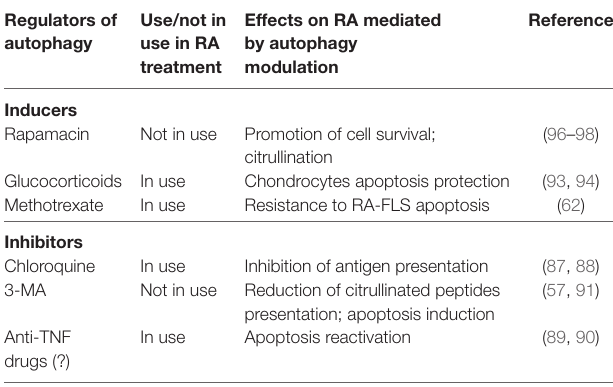
TABLe 1 | Autophagy modulators of clinical relevance in rheumatoid arthritis (RA). Regulators of Use/not in autophagy use in